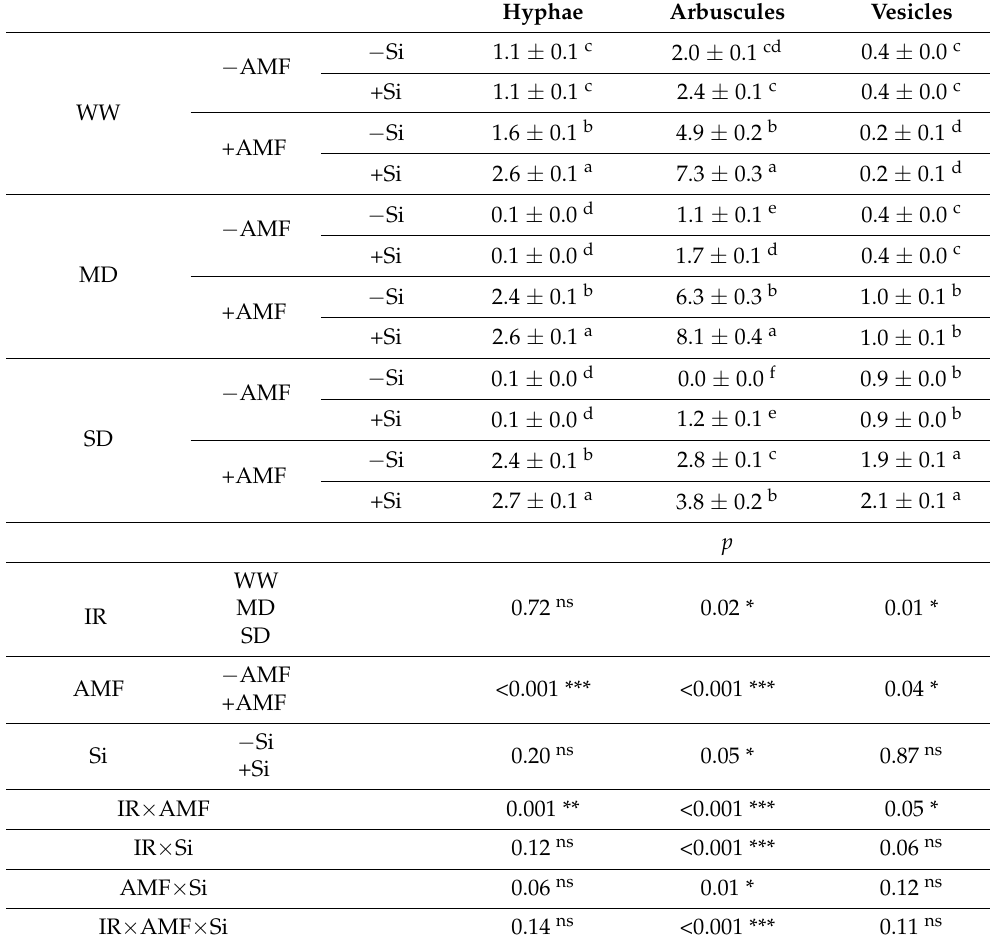
Table 1. The root colonization rate (%) in strawberry plants at harvest after six experimental weeks under three irrigation regimes (IR): well-watered (WW), mild drought (MD), and severe drought (SD) without ( − AMF) or with inoculation with arbuscular mycorrhizal fungus (+AMF) Rhizophagus clarus (Walker & Schüßler), in the absence ( − Si) or presence of silicon (+Si, 3 mmol L − 1 Na 2 SiO 3 ). The numbers show the treatment means (4 replicates) ± SE of the mean. Means with the same letters are not significantly different. The interactions among the main factors include *** p < 0.001, ** p < 0.01, * p < 0.05, and ns as not significant (Tukey test, alpha =